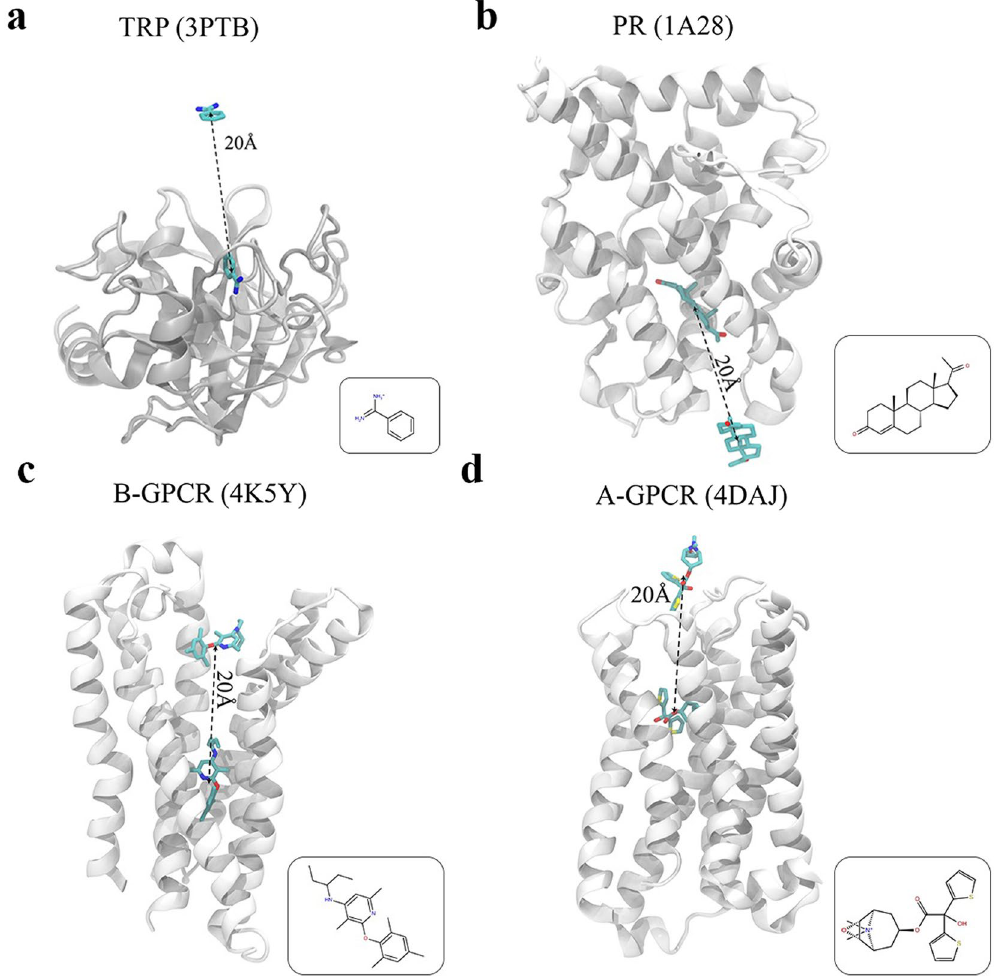
Figure 1. Protein-ligand complexes studied. ( a ) Trypsin with benzamidine as a ligand (TRP, PDB ID: 3PTB). ( b ) Progesterone nuclear hormone receptor with progesterone as a ligand (PR, PDB ID: 1A28). ( c ) Corticotropin-releasing factor GPCR with CP-376395 as a ligand (B-GPCR, PDB ID: 4KY5). ( d ) M3 muscarinic acetylcholine GPCR with tiotropium as a ligand (A-GPCR, PDB ID: 4DAJ). The initial structures for the protein-ligand exploration, with the ligand ~20 Å away from the binding site, are shown. The square inset in each panel depicts a 2D scheme of each